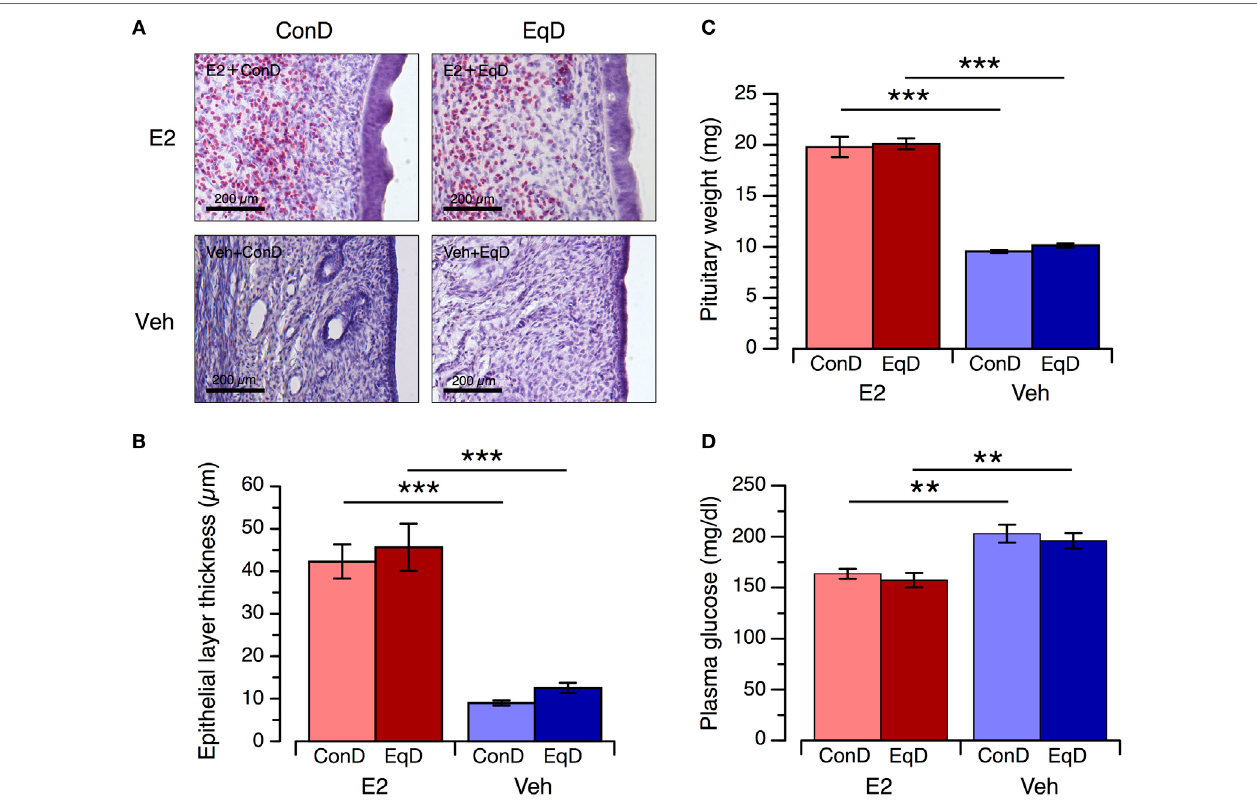
FigUre 6 | The effect of estradiol (E2) replacement and dietary S -equol on the endometrial epithelial layer thickness, pituitary gland weight and plasma glucose concentration. Rats were ovariectomized and assigned to the E2-replaced or cholesterol [vehicle (Veh)]-treated group. These rats were fed a standard (control) diet (ConD) or an S -equol-containing diet (EqD). Samples were obtained on the 13th day after ovariectomy. (a) Representative light microscopy images of the epithelial layer of the endometrium in the estradiol-replaced (E2) and Veh-treated rats fed a control (ConD) or an S -equol-containing (EqD) diet. B, C and D: the endometrial epithelial layer thickness (b) , pituitary gland weight (c) and plasma glucose concentration (D) . Values are shown as the mean ± SEM ( n = 10 in E2 + ConD; n = 10 in E2 + EqD; n = 11 in Veh + ConD; n = 12 in Veh + EqD). ***, indicates a significant difference ( P < 0.001) between the E2-replaced and Veh-treated rats fed the same